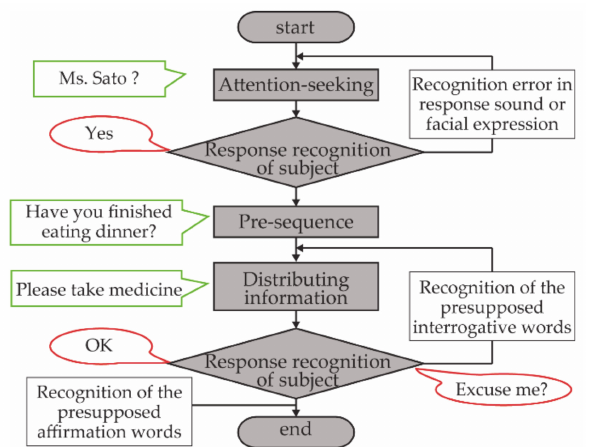
Figure 3. Information support algorithm that was developed to reliably convey information to older people.